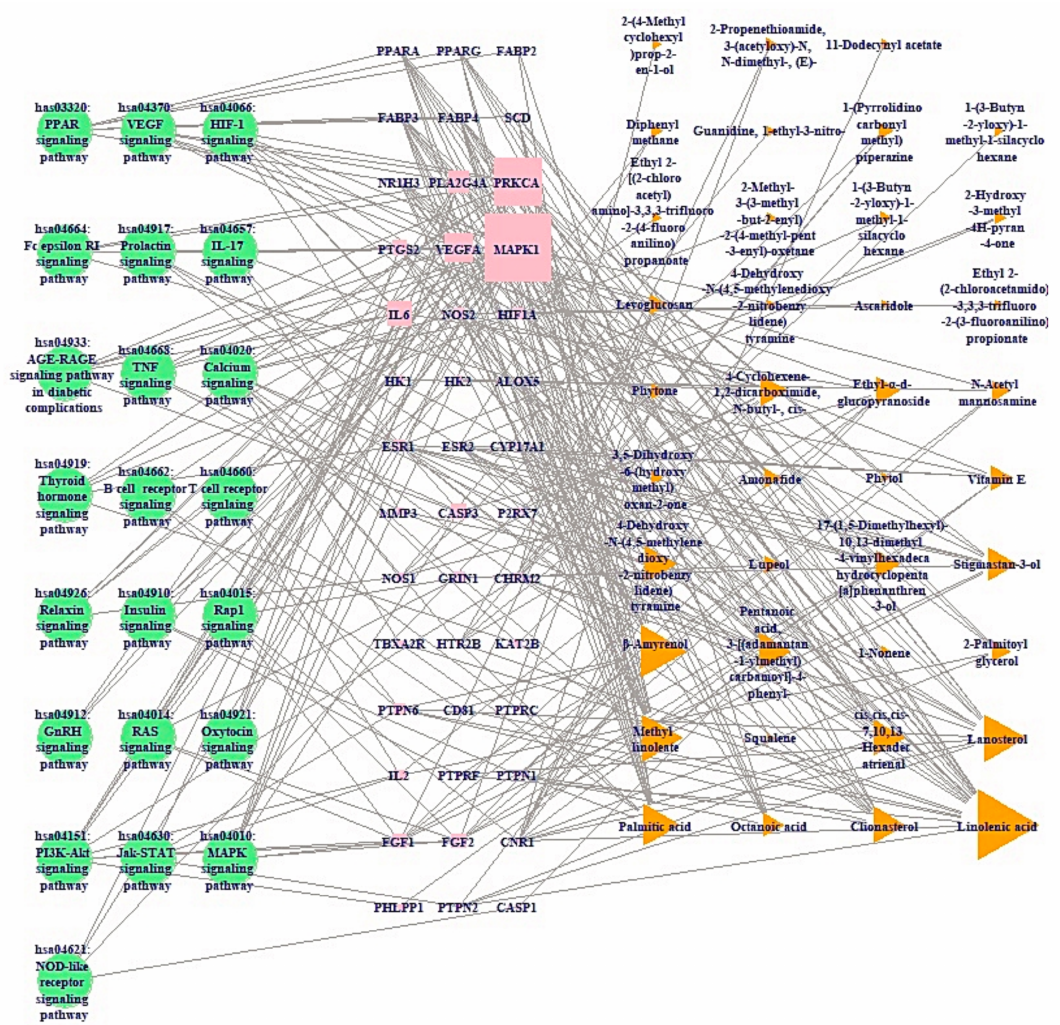
Figure 6. STC networks. Green circle: signaling pathway; pink square: target protein; orange triangle: compound. KEGG pathway revealed location of the three target proteins (IL6, MAPK1, and CASP1) in intracellular components (Figure